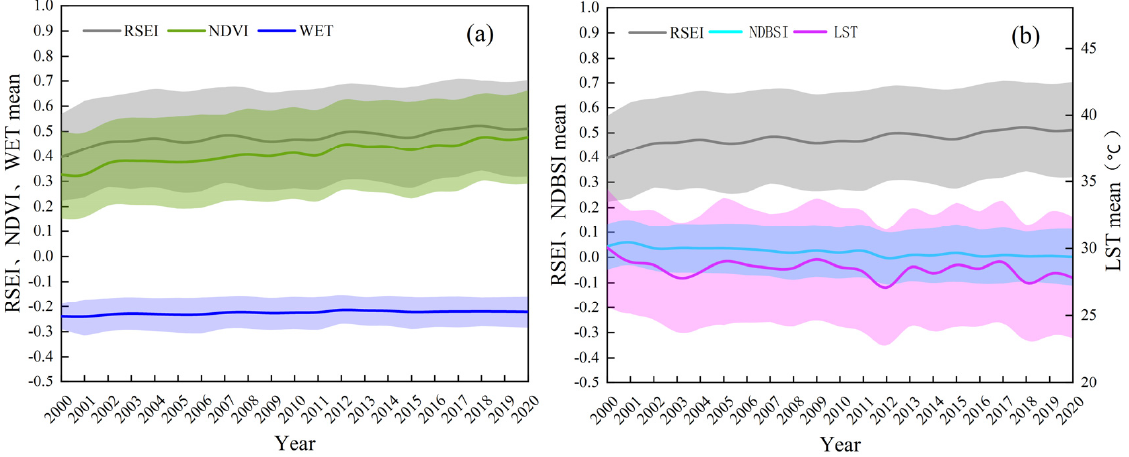
Figure 3. The interannual variation trend of each indicator. ( a ) the regional averages of RSEI, NDVI, WET indicators, and ( b ) the regional averages of RSEI, NDBSI, LST indicators.